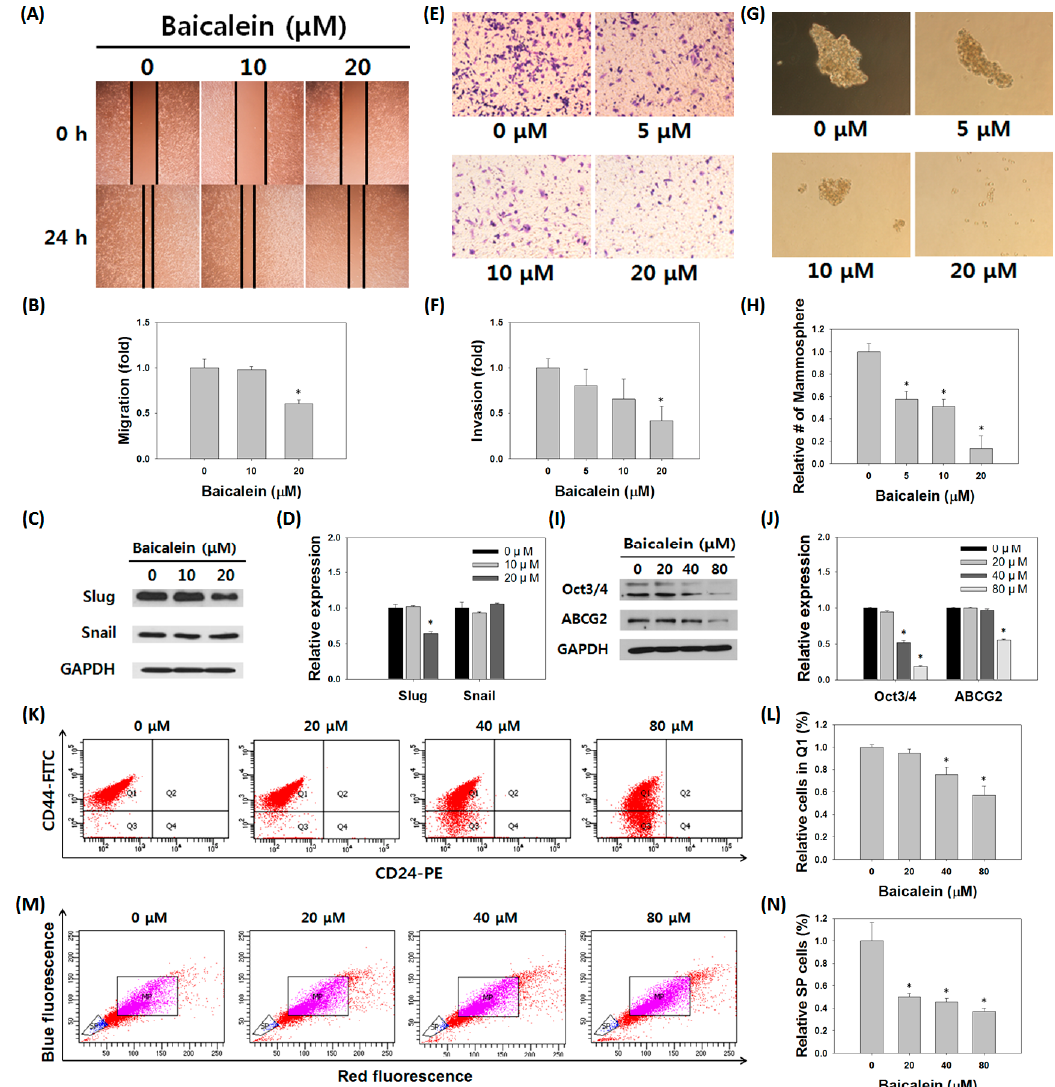
Figure 5. Effects of baicalein on characteristics of MDA-MB-231/IR cells. ( A , B ) Migration assay and ( C , D ) Western blot analysis of EMT proteins in MDA-MB-231/IR cells were performed after baicalein treatment for 24 h. GAPDH was used as a control; band intensities were quantified using ImageJ. Effects of baicalein on stem cell-like characteristics were determined by ( E , F ) invasion assay for 24 h and ( G,H ) mammosphere formation assay for one week. ( I , J ) Western blot assay for stem cell markers in MDA-MB-231 cells after baicalein treatment for 24 h. ( K , L ) The percentage of expression of cell surface markers and ( M , N ) side population (SP) on MDA-MB-231/IR cells were detected by FACS after baicalein treatment for 24 h. Asterisks (*) indicate significant differences at p <